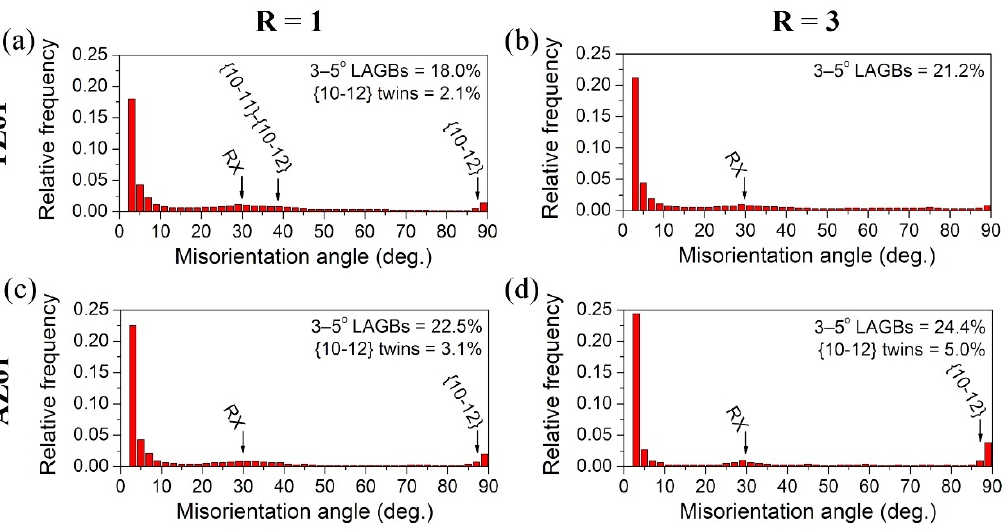
Figure 2. The misorientation angle distributions of the as-rolled ( a , b ) TZ61 and ( c , d ) AZ61 sheets processed at speed ratio of: ( a , c ) R = 1 and ( b , d ) R = 3.